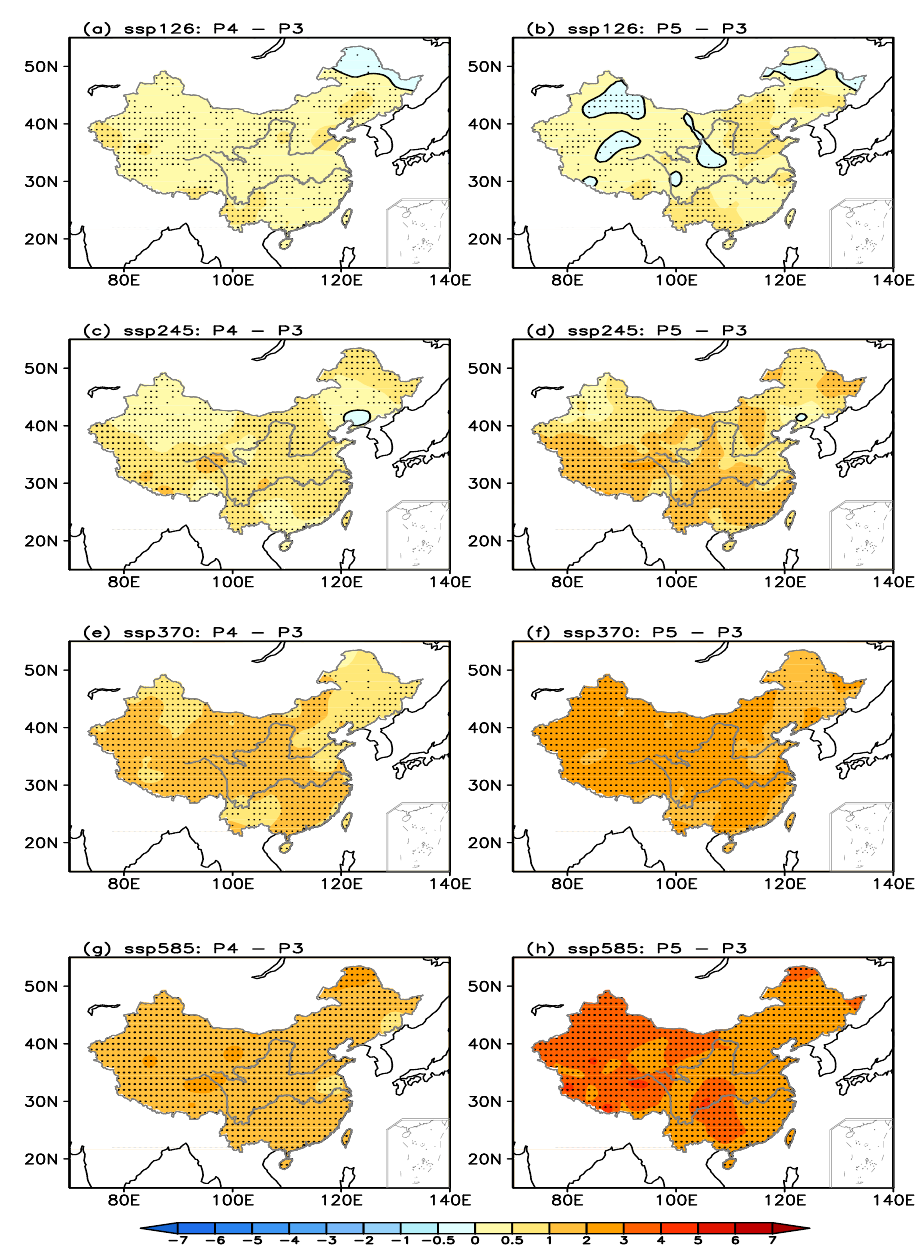
Fig. 7 Spatial difference dis- tribution of HTx with RP-50 yr between two periods under different emission scenarios (Units in °C, the black dots are for the same symbol of models larger than